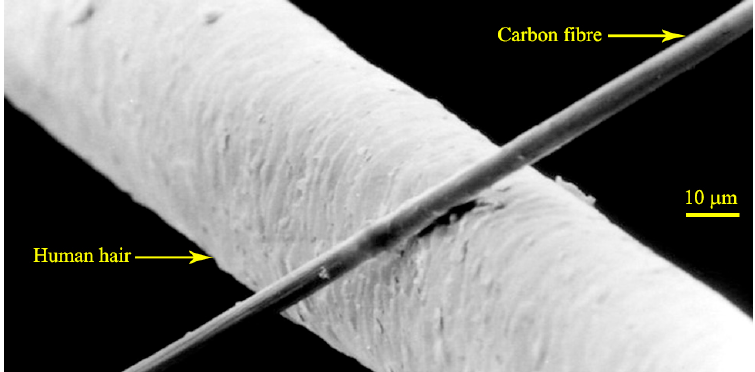
Figure 3. Carbon fiber compared with human hair (photo credit: Anton).